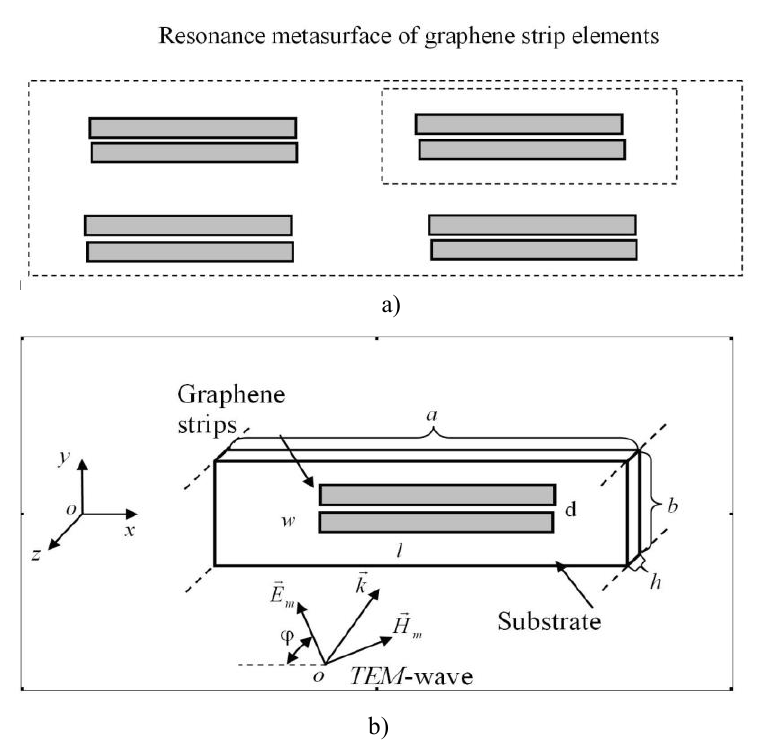
Fig. 1. Geometry of metasurface for the diffraction problem: a) periodic graphene structure on the dielectric (or multilayer) substrate, b) model of the unit cell of the array; direction of incident TEM - wave of wave vector k ; φ - angle of orientation of the electric field E respective to graphene strip; periodicity a, b; w – width, l – length of graphene strip; d — distance between strips; h – thickness of substrate.